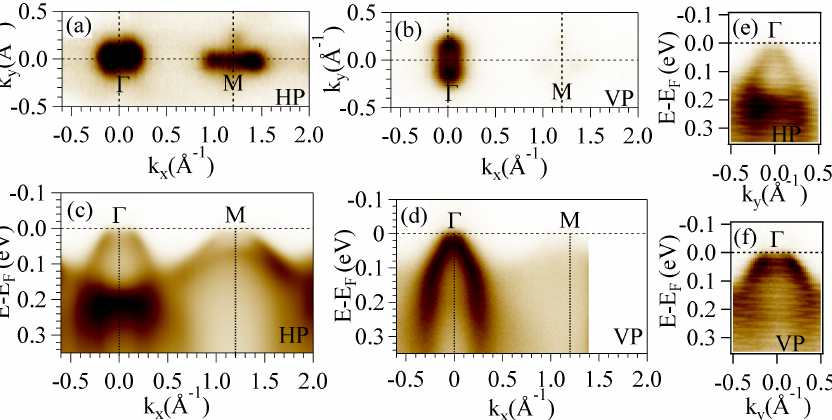
Figure 6. ARPES measurements of a 28-uc FeSe film deposited at d = 7.5 cm on CaF 2 measured with a photon energy of 85 eV at 45 K. ARPES maps measured with ( a ) HP ( b ) VP of the light. ( c , d ) Horizontal cuts along the Γ -M direction; ( e , f ) vertical cuts along the Γ direction taken from ( a ) and ( b ),